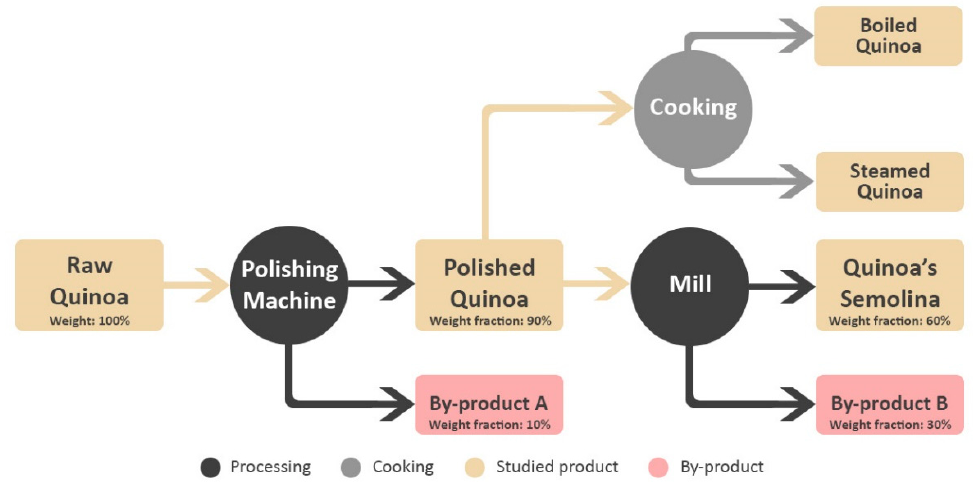
Figure 1. Studied quinoa processing and cooking